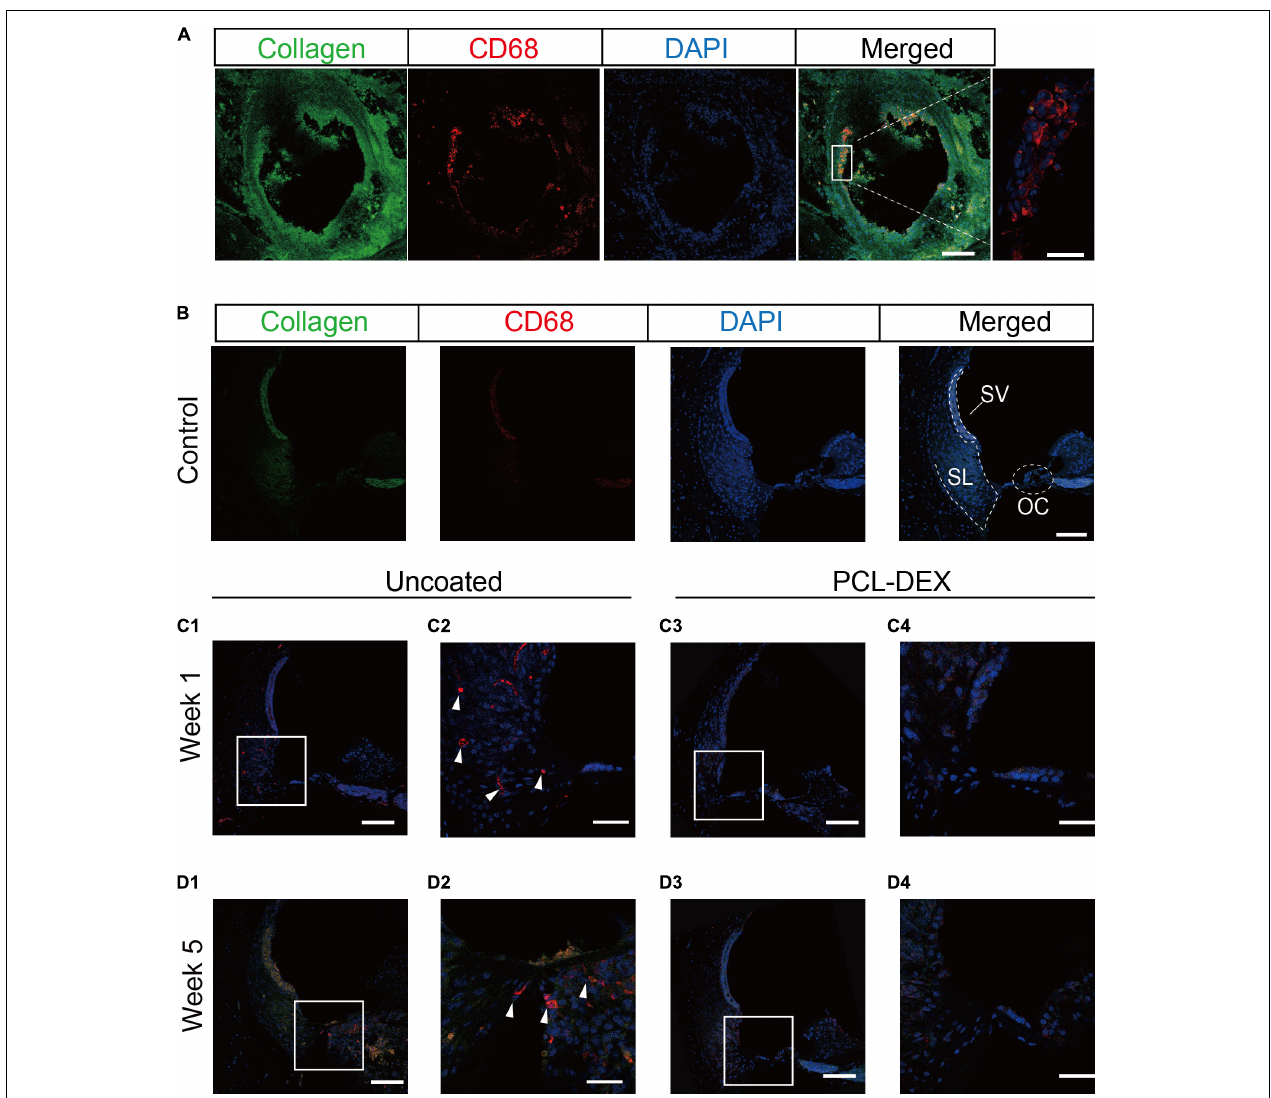
FIGURE 8 | Confocal images of macrophages expressed in the cochlea. (A) Representative immunostaining images showing the proliferative tissue in the tympanic scala 5 weeks after implantation. CD68 (red) and type I collagen (green) were evident in the proliferative tissue, especially on the surface of the electrode (magnified view, right panel). Scale bar = 100 and 20 µ m for the left and right panels, respectively. (B) Representative immunostaining images showing the spiral ligament in the control cochlea. SL, spiral ligament; SV, stria vascularis; OC, organ of Corti. (C) Representative immunostaining images showing the spiral ligament of the basal